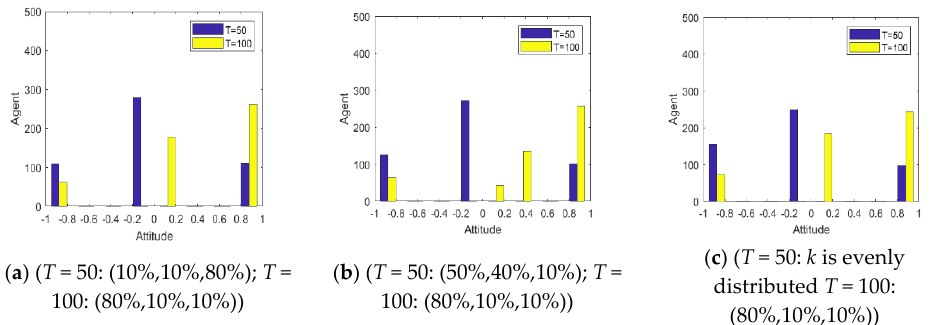
Figure 16. Distribution histogram of group attitude with different conservation proportion at different times. ( a ) ( T = 50: (10%,10%,80%); T = 100: (80%,10%,10%)); ( b ) ( T = 50: (50%,40%,10%); T =